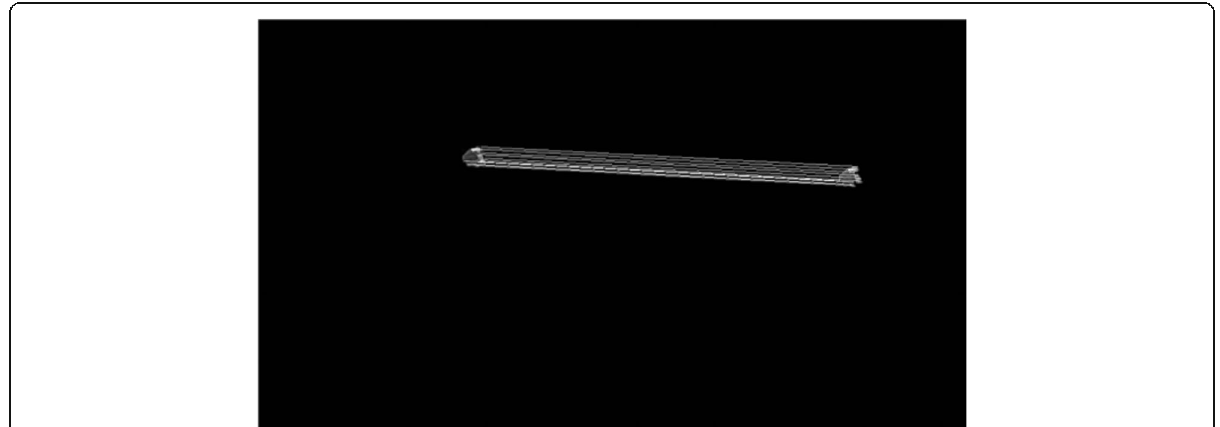
Fig. 8 Foreign object matching in left and right views